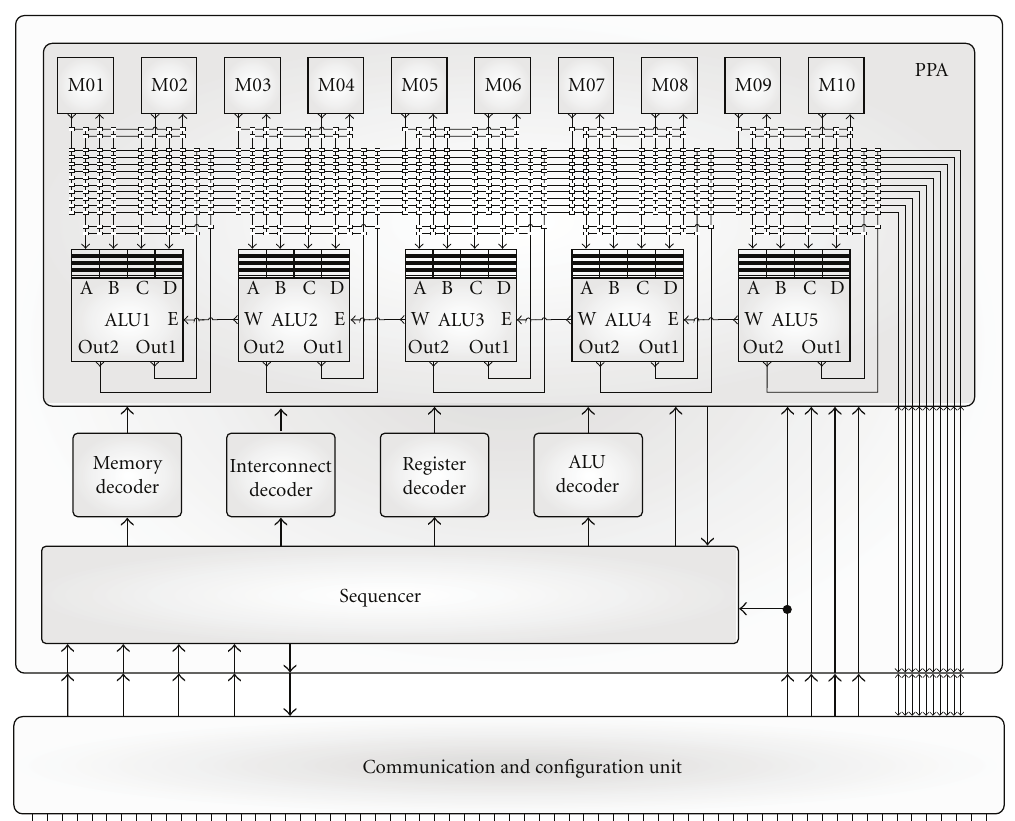
Figure 4: Montium processing tile, consisting of a Montium TP and a CCU.